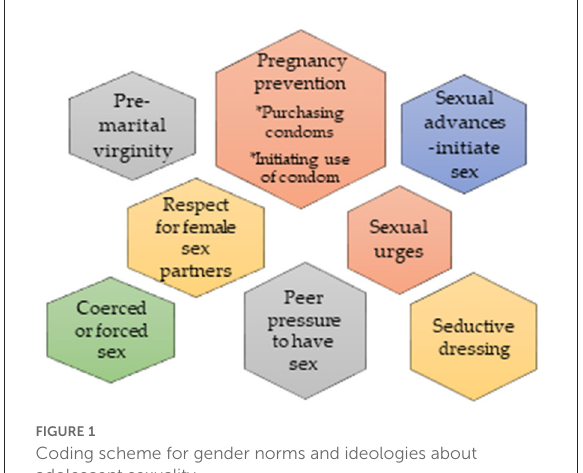
FIGURE1 Coding scheme for gender norms and ideologies about adolescent